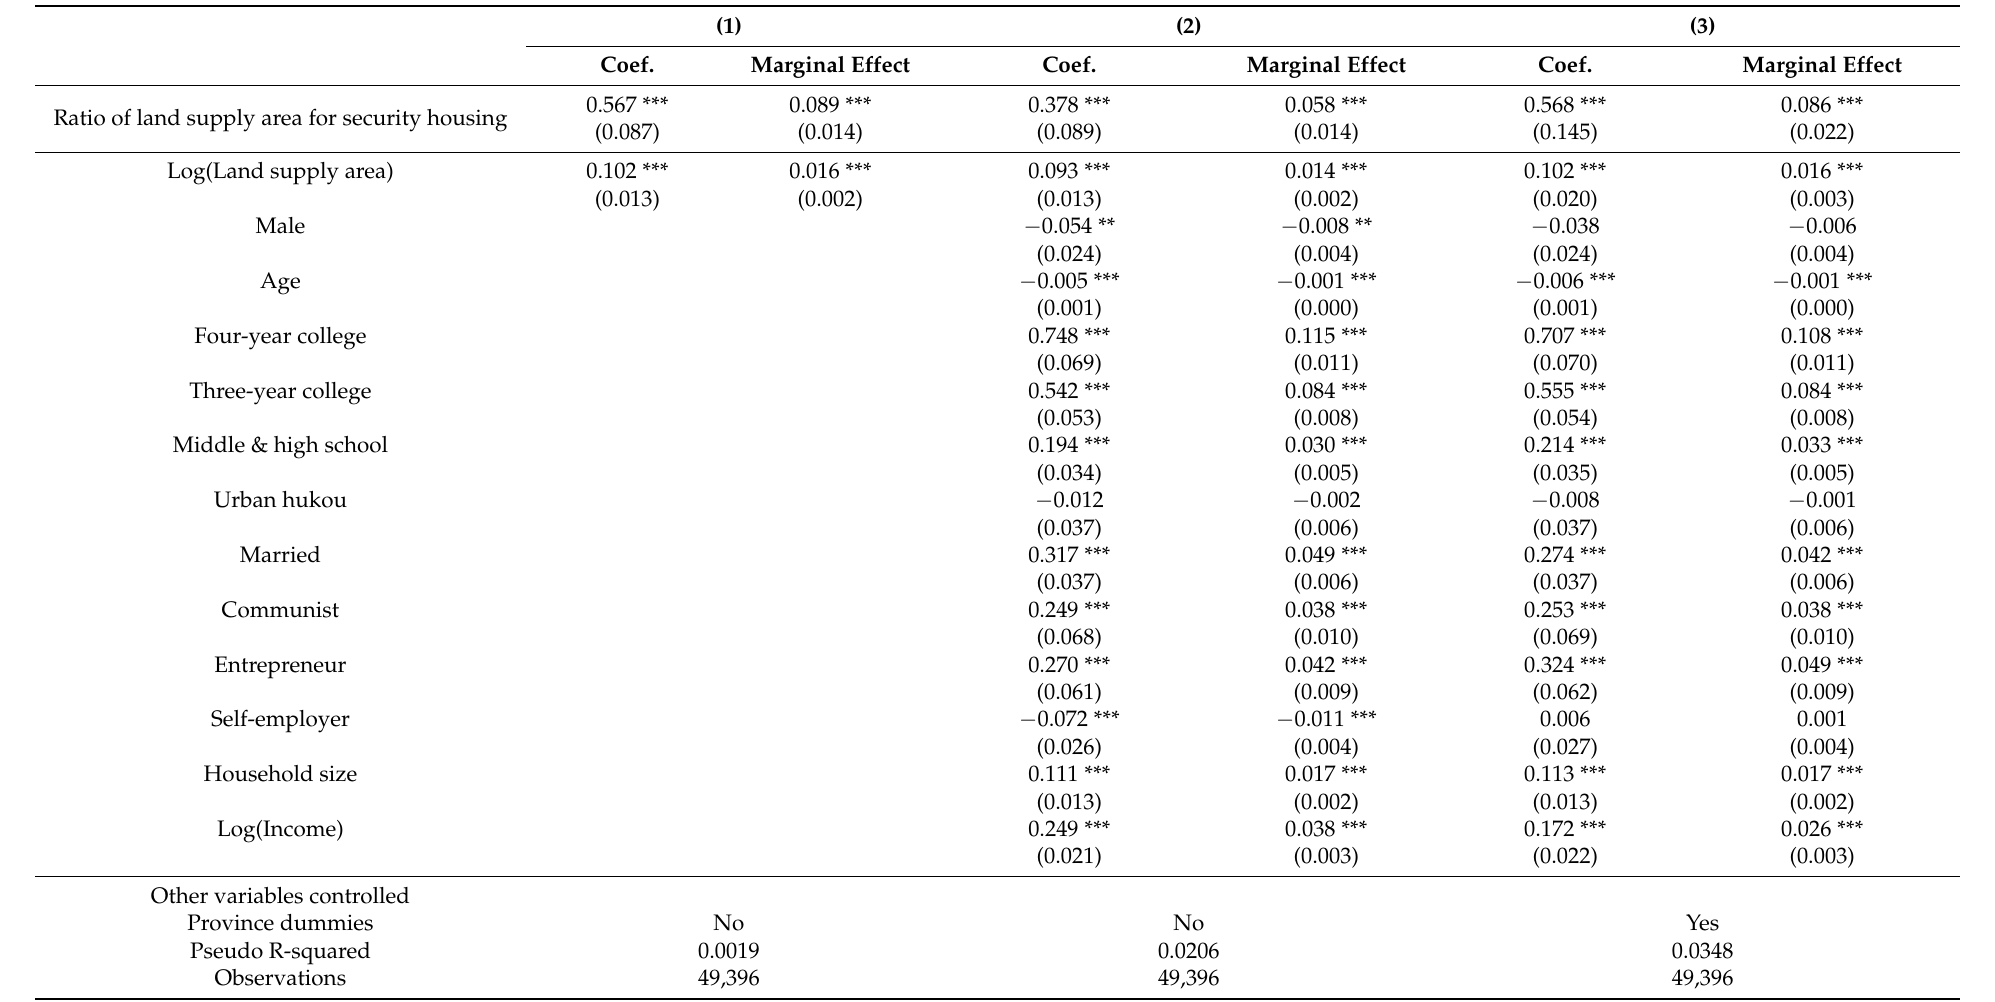
Table 2. Estimated results of housing security and settlement intentions (Logit